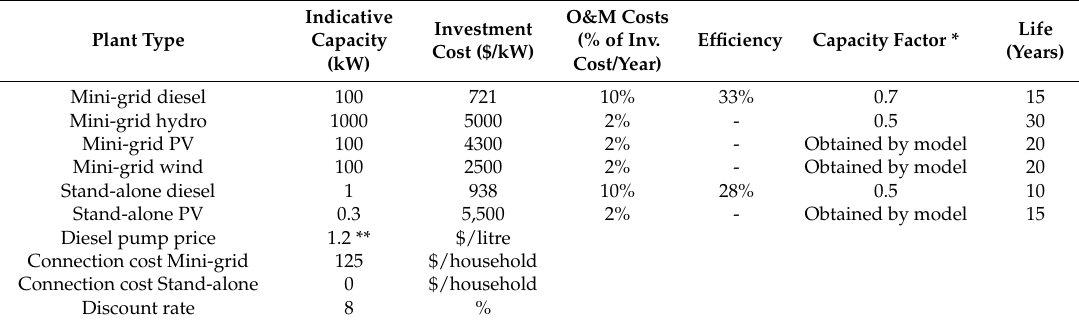
Table A2. Techno-economic parameters for off-grid technologies included in the electrification